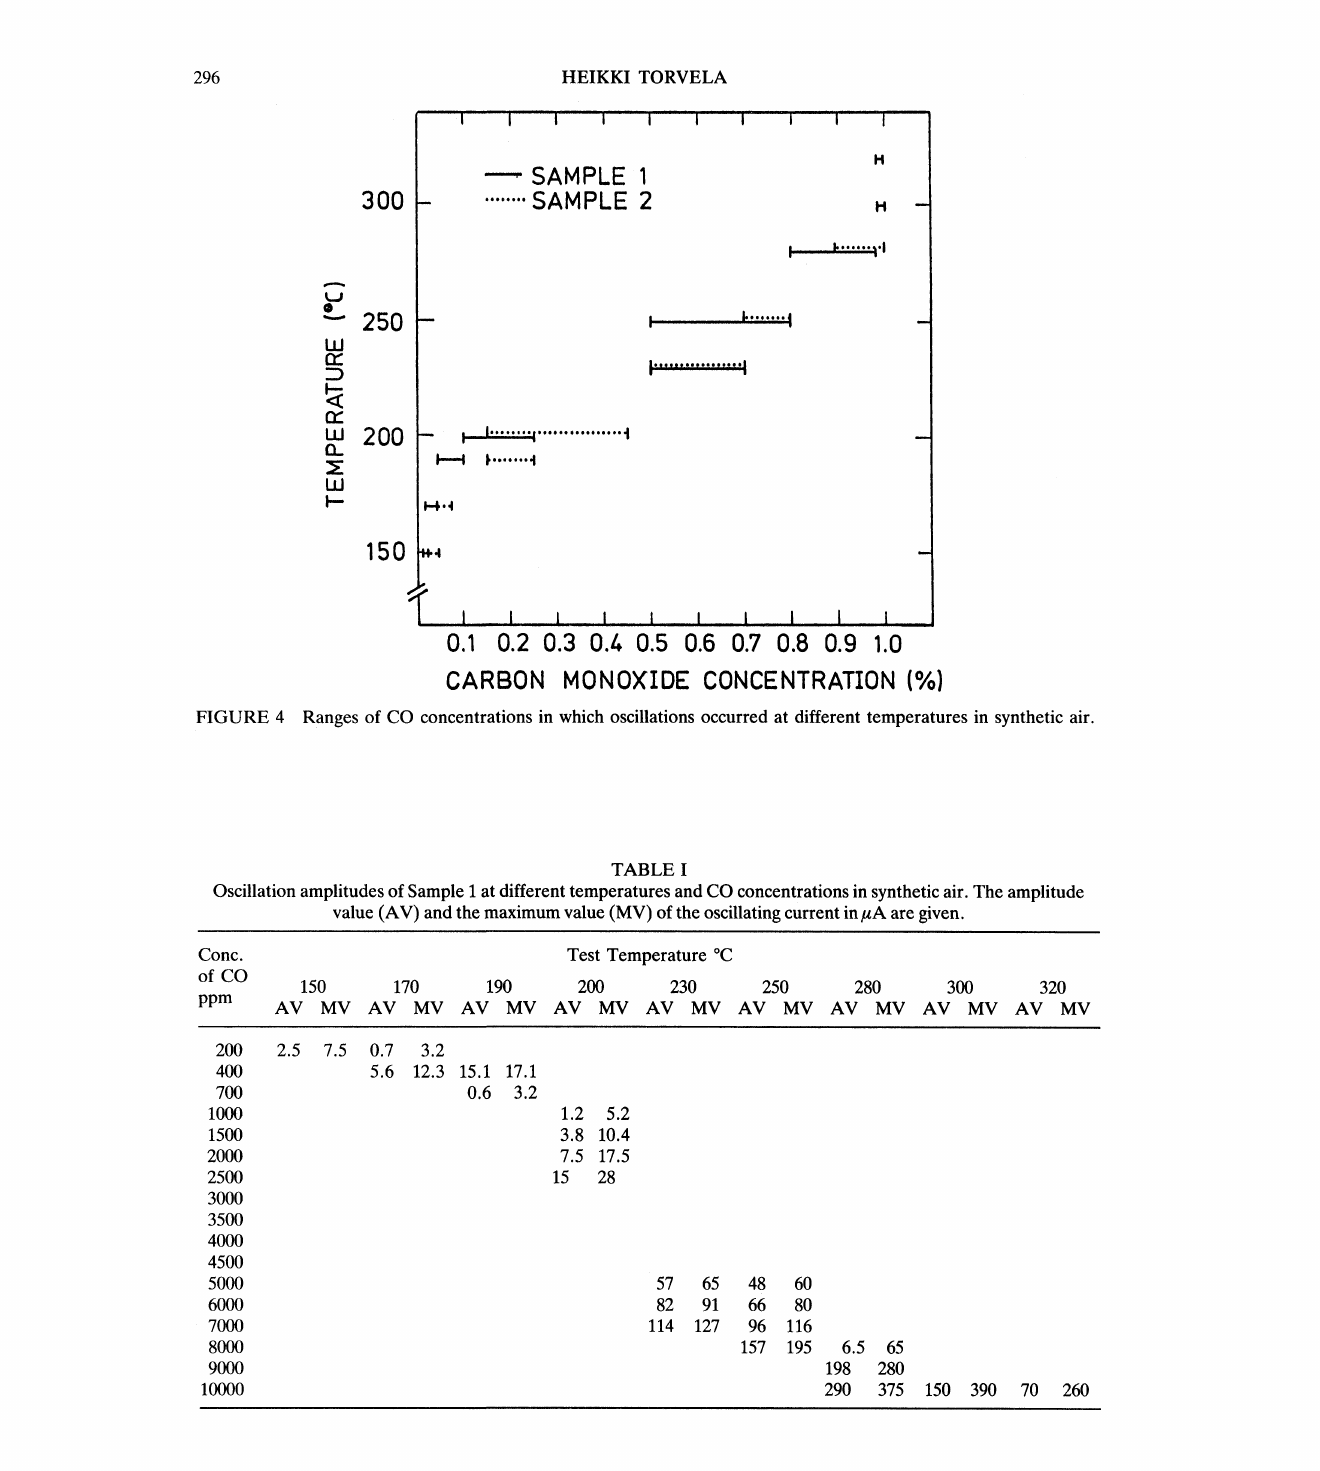
TABLE Oscillation amplitudes of Sample at different temperatures and CO concentrations in synthetic air. The amplitude value (AV) and the maximum value (MV) ofthe oscillating current in #A are given. Conc. of